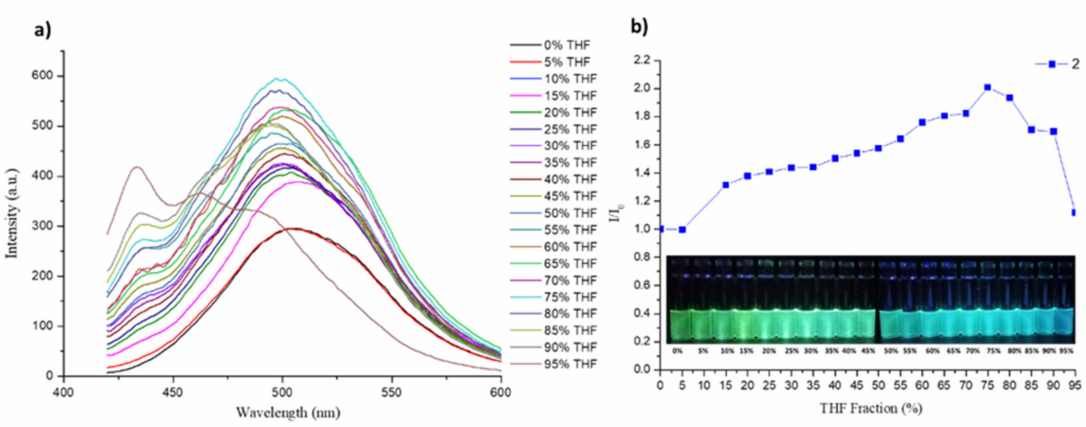
Figure 14. ( a ) Room-temperature emission spectra of 2 in MeOH/THF solvent mixtures of different proportions upon excitation at 324 nm. ( b ) Plot showing the increase in the relative emission intensity of 2 in a MeOH-THF solvent mixture with increasing THF fraction. Inset: vials of the various samples under 365 nm UV-lamp